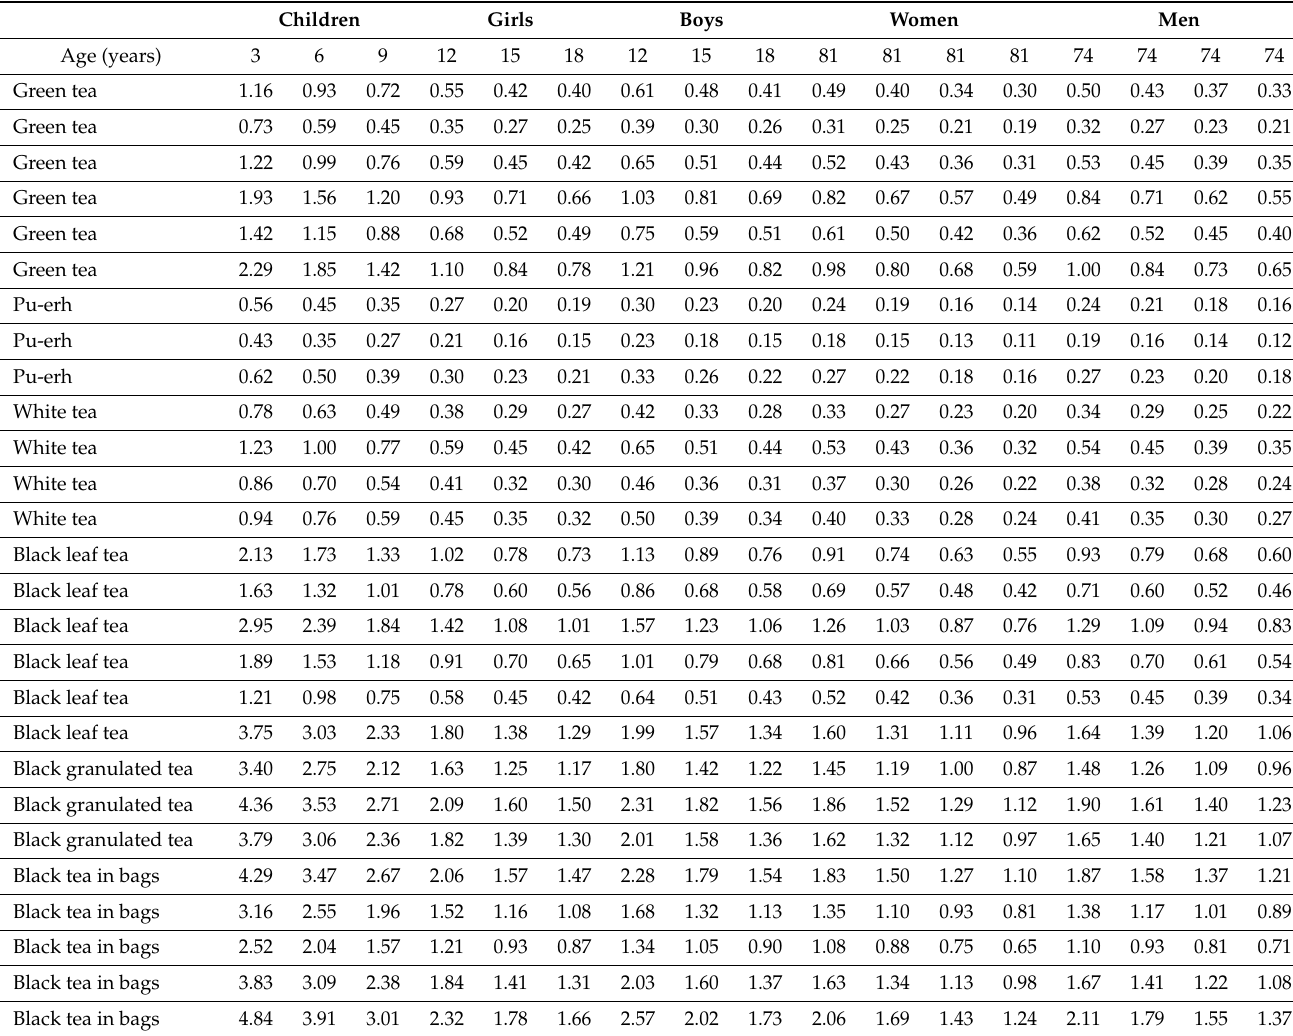
Table 3. Values of the THQ parameter for various population